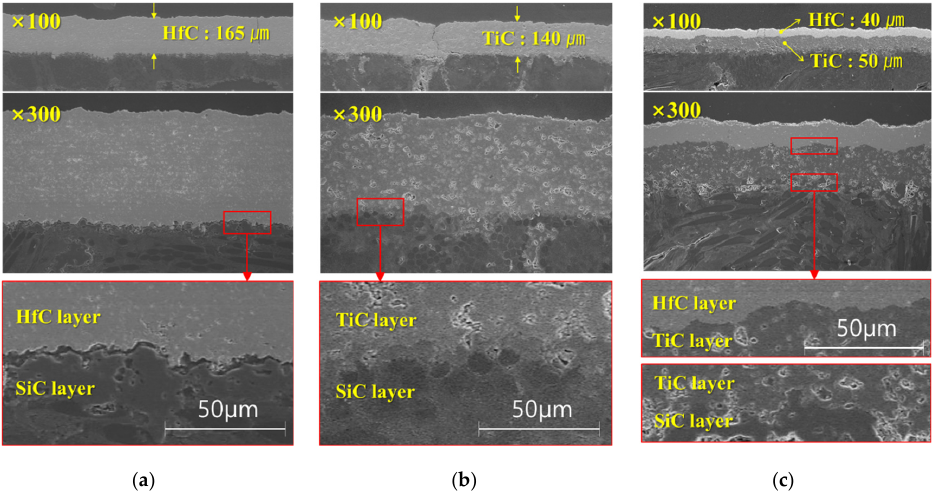
Figure 4. FE-SEM images of ( a ) HfC coating, ( b ) TiC coating, and ( c ) HfC/TiC coatings.